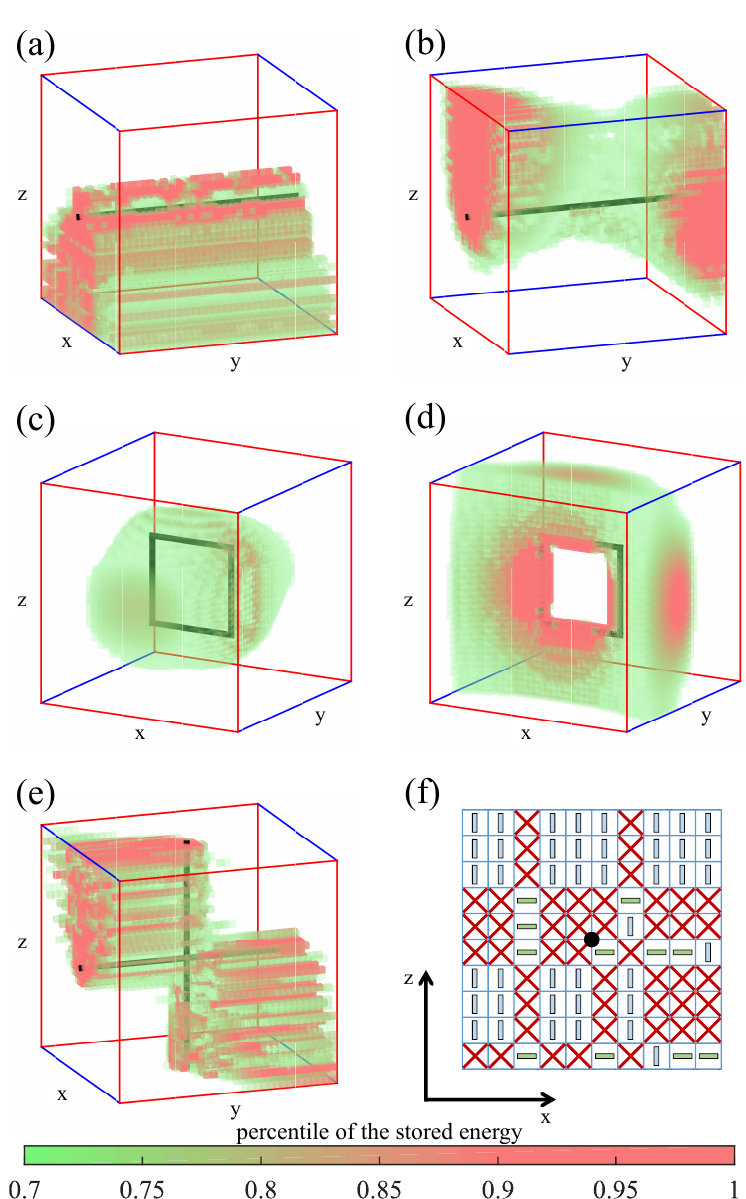
Figure 7: (a) Compatible actuation on the back and front faces can concentrate stresses beneath the defect line. (b) Twisting the stressed region through actuation on the incompatible left and right faces. (c,d) Compatible actuation on the front and back faces concentrates stresses outside (c) or inside (d) a defect loop. (e) Com- patible actuation on the front and back faces concentrates stresses on two separated quadrants. Color bar indicates the percentile of the stored energy, separately calcu- lated for each case. The faces on which the actuation is applied are indicated by red frames. (f) Partial cross section close to the centered defect line of the structures in (a,b), showing the non-periodic internal architecture. In this top view, building blocks oriented along the y axis are represented by a red cross (cf. Fig. 6(c,d)), whereas building blocks oriented along the x and z axes are represented by hor- izontal and vertical rectangles, respectively. All calculations are for metacubes of dimension 35 × 35 ×